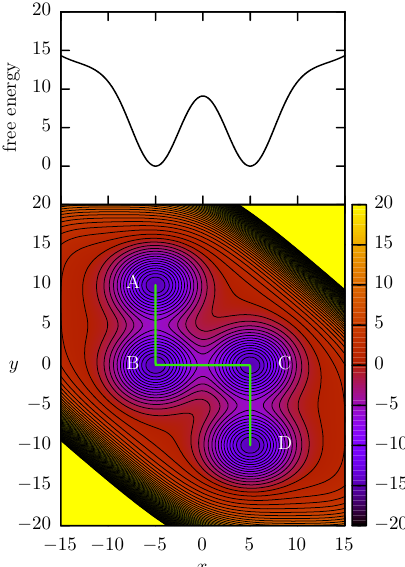
Figure 1. Kink-shaped potential-energy sourface (k-PES) together with its free-energy profile (FEP) along the x coordinate. The minimum energy path (MEP) is shown in white on the surface and its profile is included in Figure S1 of the Supplementary Materials. The barrier height along the MEP is around